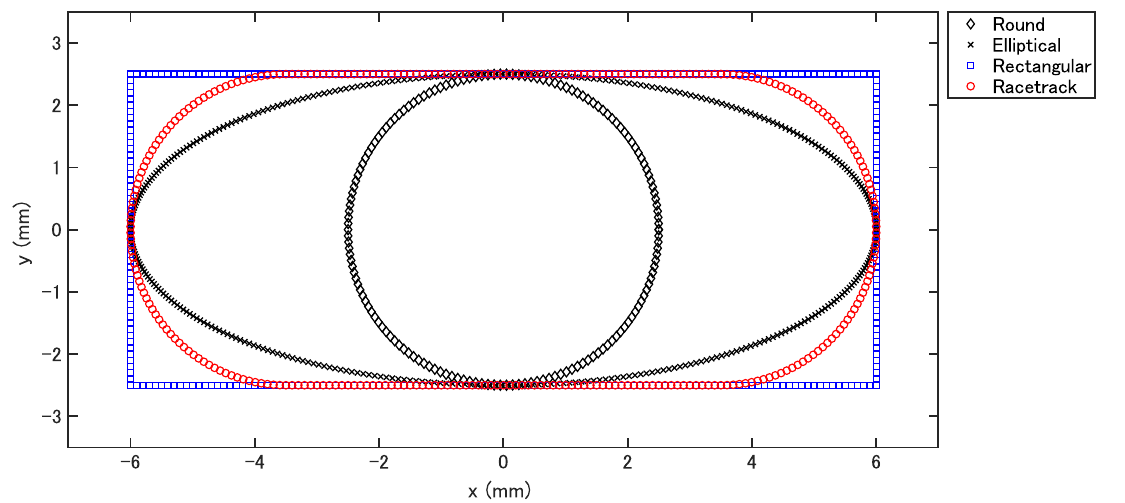
FIG. 8. Numerical models of vacuum chamber cross-section geometries used for the boundary element method: round, elliptical, rectangular, and racetrack. The above shown points denote the boundary nodes.